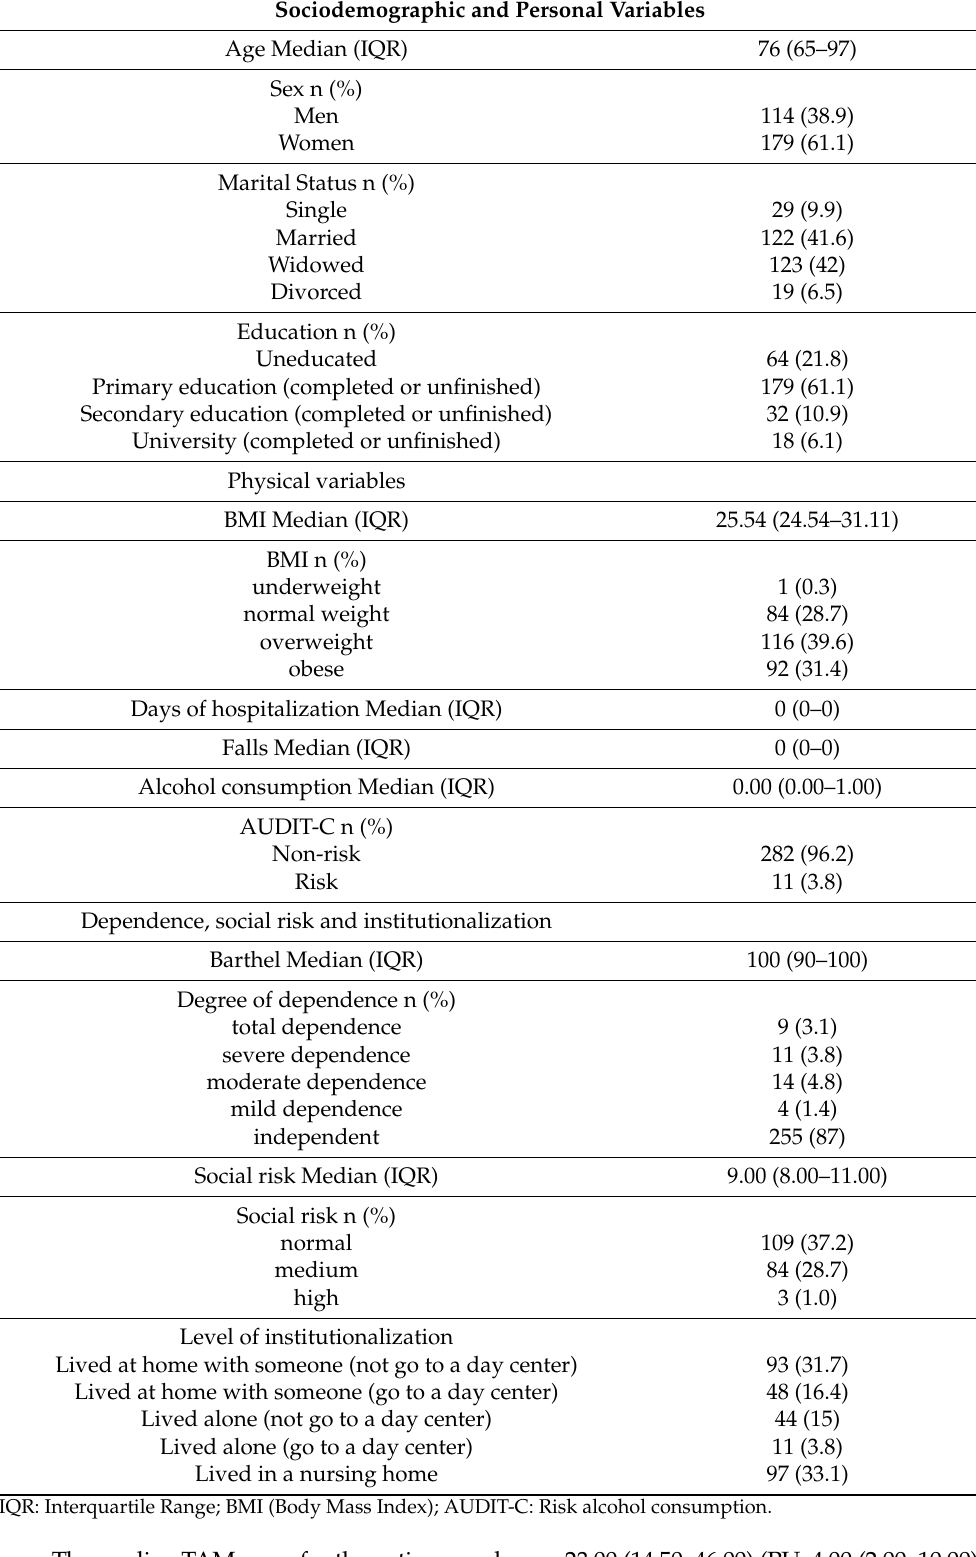
Table 1. Characteristics of the entire sample (n =